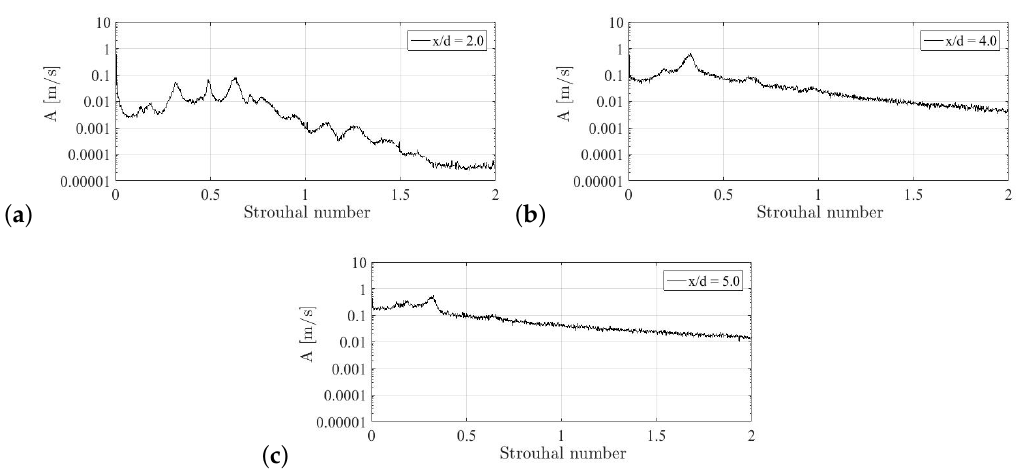
Figure 11. Evolution of spectra of axial velocity fluctuations, S = 0.5, L / D = 1, Re = 5000: ( a ) x / D = 2, ( b ) x / D = 4, ( c ) x / D = 5